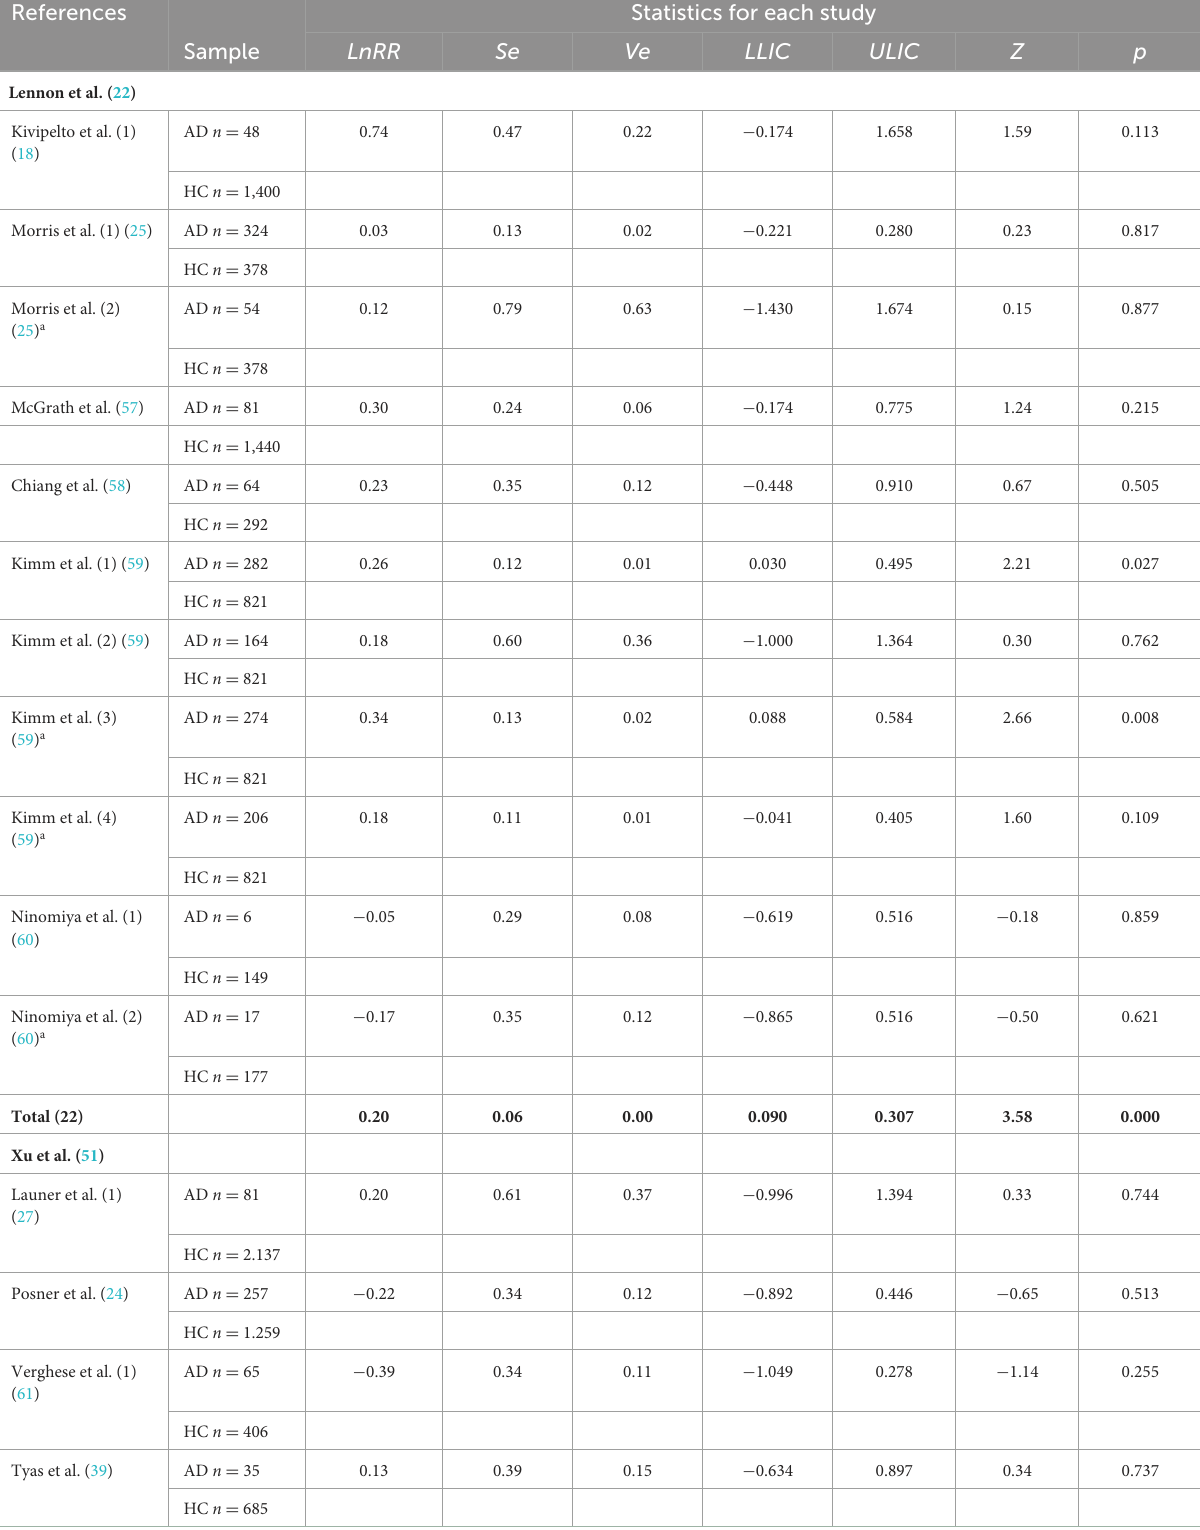
TABLE 2 Individual and pooled estimates of the association between high SBP and